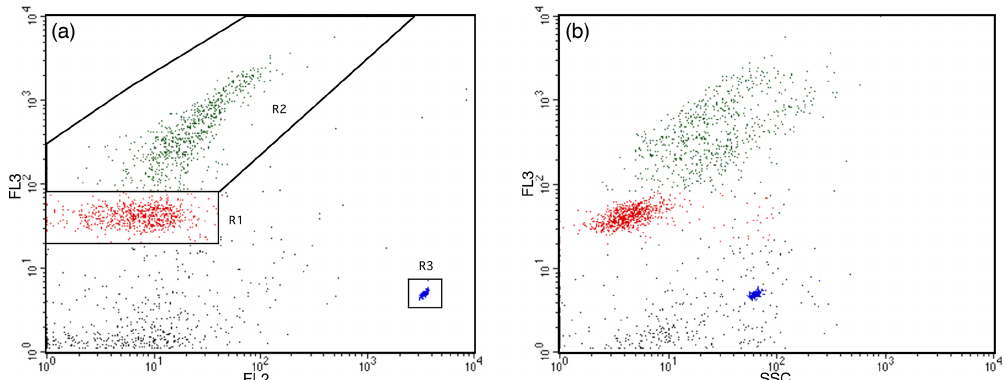
Figure 1. Nano- and picophytoplankton regions identified by flow cytometry. (a) Two separate regions identified based on red (FL3) versus orange (FL2) fluorescence scatter plots. (b) Picophytoplankton (R1) and nanophytoplankton (R2) communities determined from side scatter (SSC) versus FL3 fluorescence scatter plots. PeakFlow Green 2.5µm beads (R3) were used as fluorescence and as a size